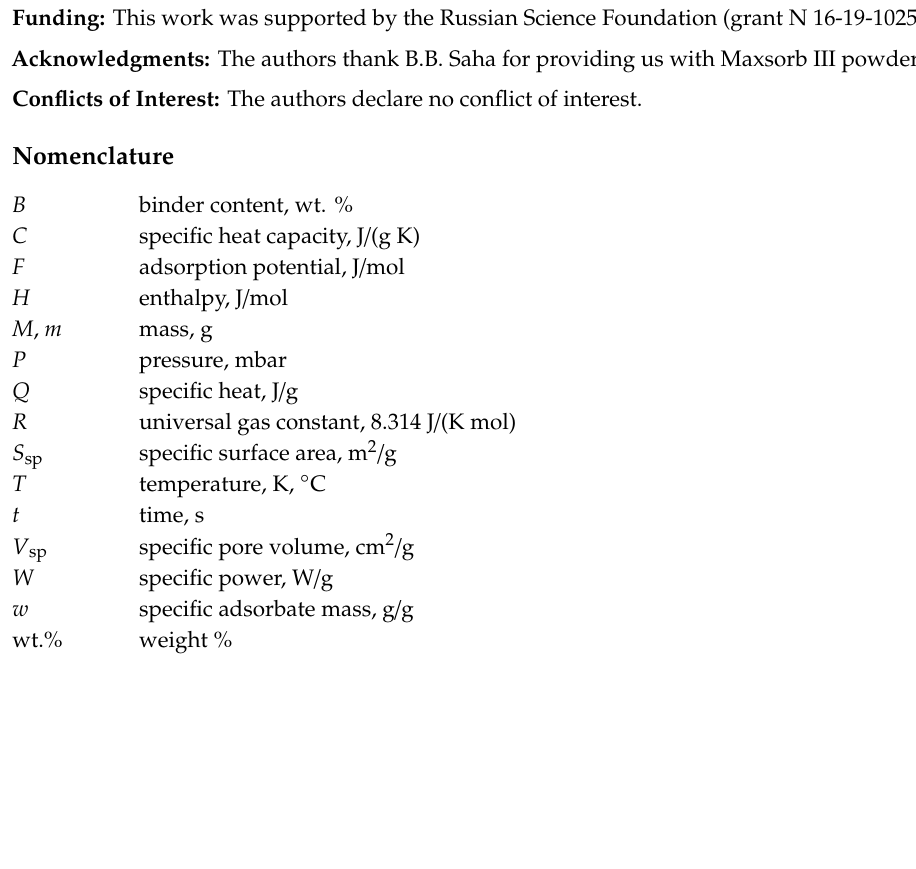
Figure S1: Isotherm of nitrogen adsorption on S(P1)120, Figure S2: Isotherm of nitrogen adsorption on S(P1)400, Figure S3: Isotherm of nitrogen adsorption on S(P2)400, Figure S4: Isotherm of nitrogen adsorption on SP(P1)120, Table S1: Experimental data of nitrogen adsorption on S(P1)120, Table S2: Experimental data of nitrogen adsorption on S(P1)400, Table S3: Experimental data of nitrogen adsorption on S(P2)400, Table S4: Experimental data of nitrogen adsorption on